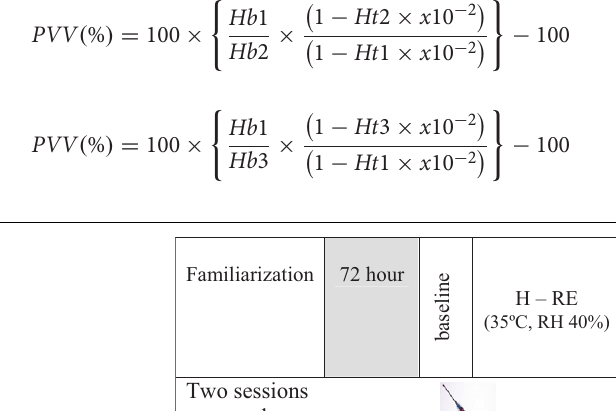
Frontiers in Physiology |